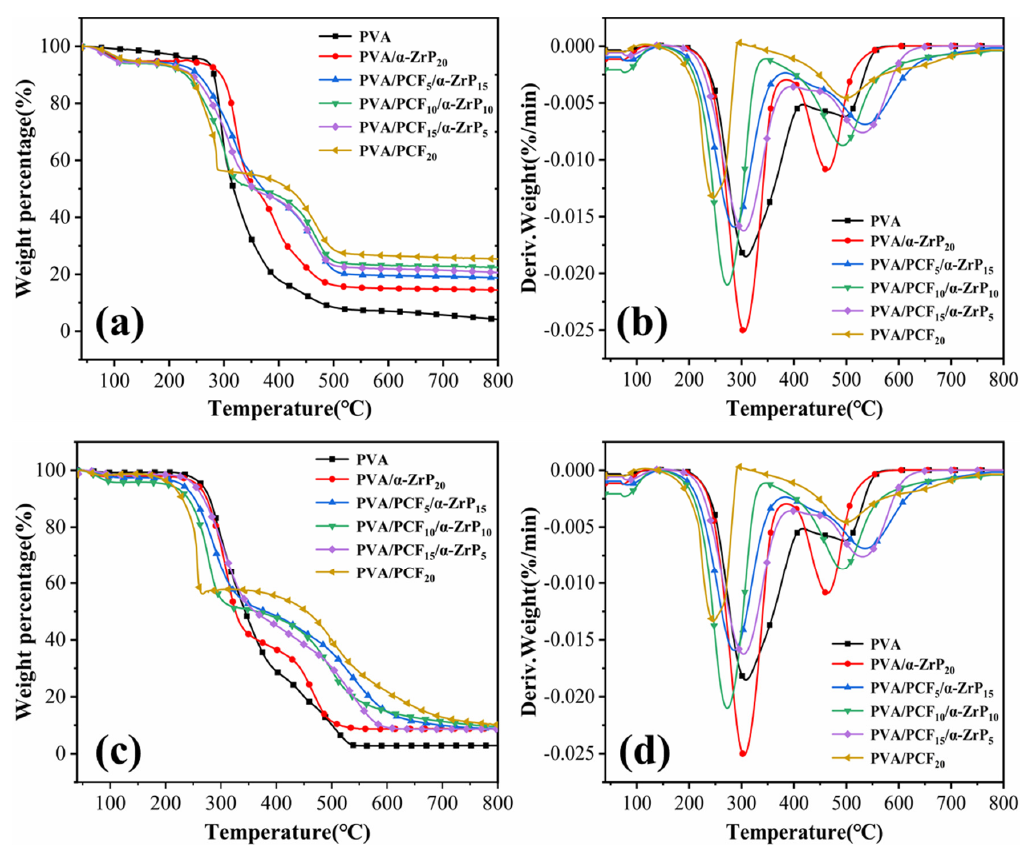
Figure 6. TGA and DTG curves of PVA/PCF x / α -ZrP y aerogel in ( a , b ) nitrogen atmosphere and ( c , d ) air atmosphere.